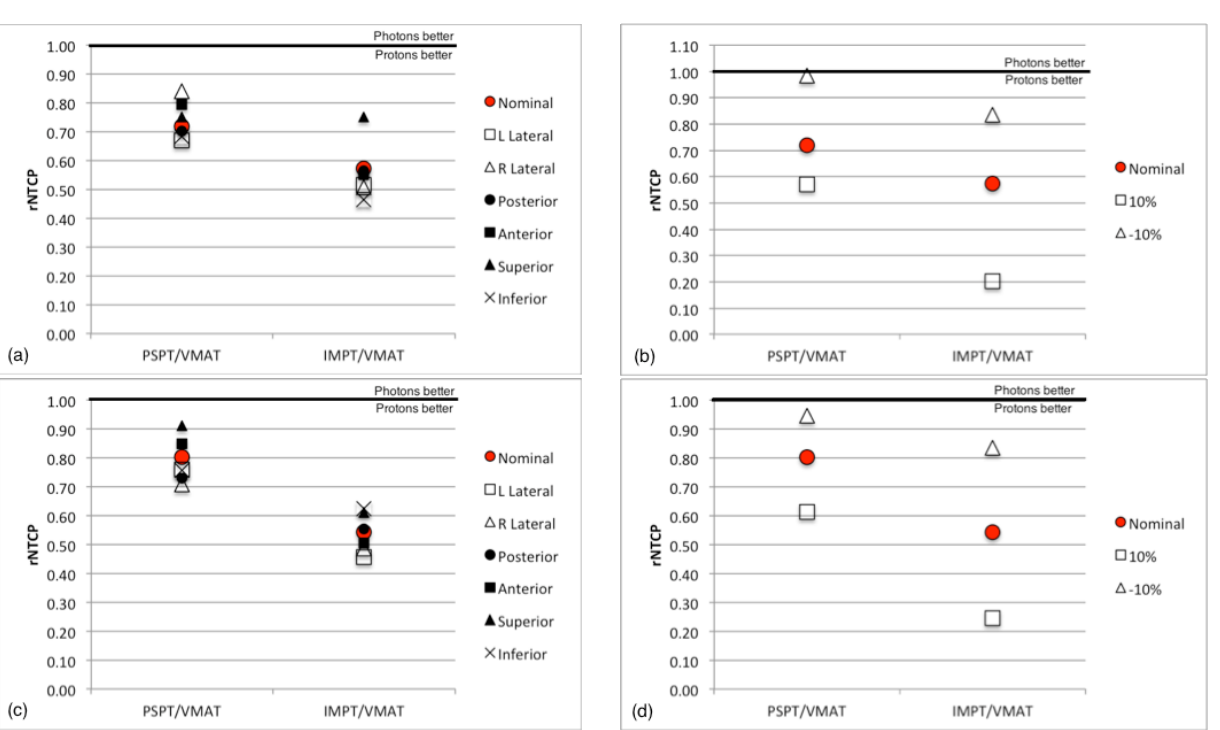
Figure 7. ( a ) The change in rNTCP with isocenter shifts and ( b ) with ±10% calibration curve errors for patient 5. ( c ) The change in rNTCP with isocenter shifts and ( d ) with ±10% calibration curve errors for patient 12.